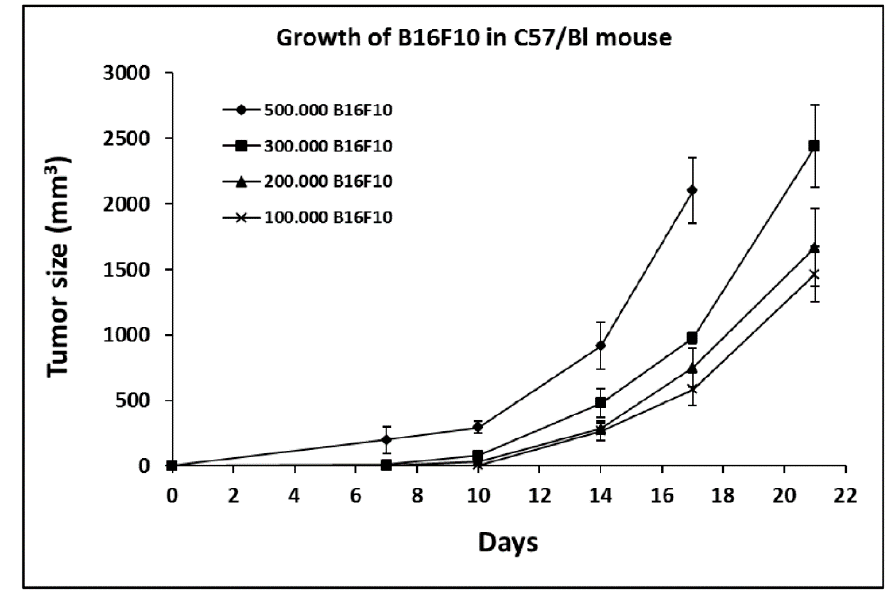
Figure 1. Growth of B16F10 in C57/BL mice. Growth curve of B16F10 in C57/BL mice inoculated with an increasing number of B16F10 cells, respectively 100,000, 200,000, 300,000 and 500,000 cells. C57/BL mice were divided into four groups and each group consisted of five animals for statistical significance. Data are expressed as means ± SE. Tumor size is expressed in mm 3 .